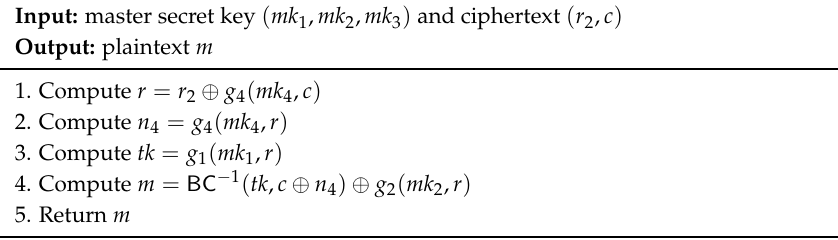
Algorithm 6 Higher-order SCA-resistant re-keying encryption scheme: dec HO −